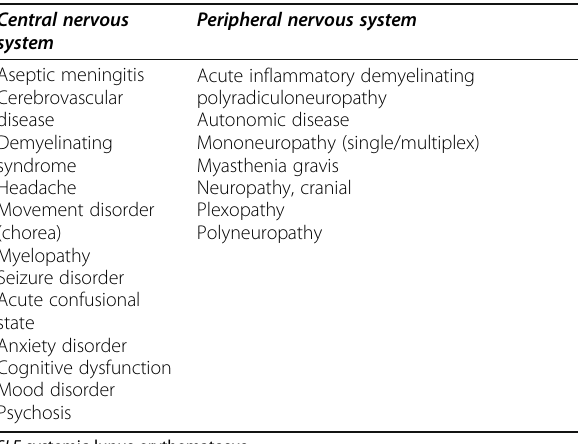
Table 1 Neuropsychiatric syndromes in SLE patients according to the American College of Rheumatology nomenclature